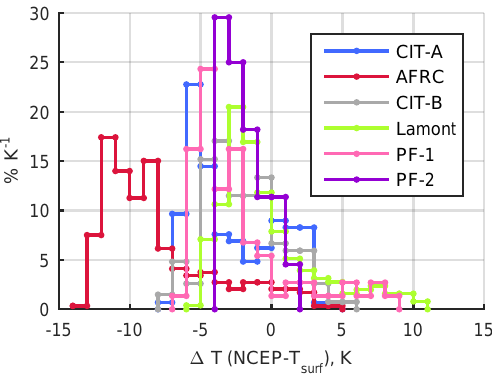
Figure 4. Histograms of differences in temperature from those used in the retrievals at the surface (NCEP model) as opposed to the tem- perature measured at the TCCON sites.